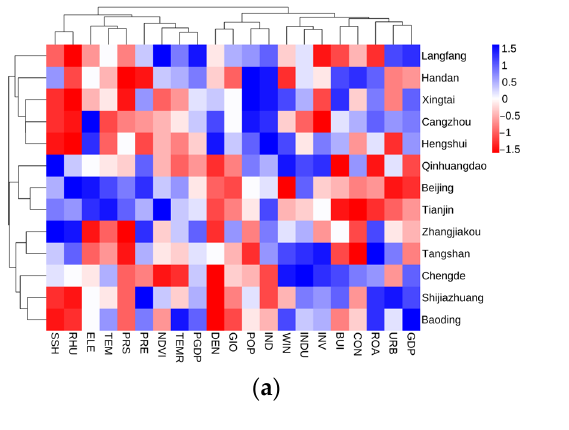
( b ) Ranking of Inc Node Purity. Each variable name is the same as in Table 1.